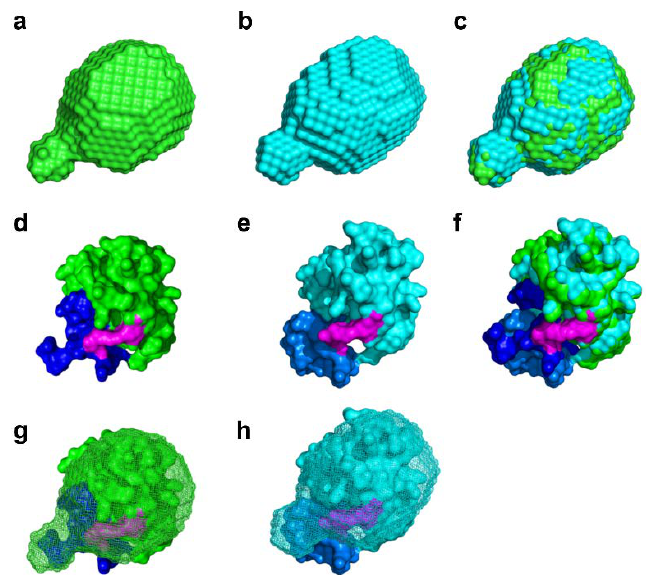
Figure 4. Molecular structures modeled from the low-resolution shape reconstruction and the experiment-restrained rigid-body MD simulation. ( a – c ) Low-resolution shape reconstruction of SML-PYP in the dark ( a ) and light ( b ) states, and the superimposed image ( c ) of DAMMIF filtered results. ( d – f ) Structural representation of SML-PYP in the dark ( d ) and light ( e ) states from the experiment-restrained rigid-body MD simulation, and the resulting superimposed image ( f ). ( g , h ) Comparison of structures from the low-resolution shape reconstruction (mesh) and the experiment-restrained rigid-body MD simulation (sphere-dot) of SML-PYP in the dark ( g ) and light ( h ) states. Blue and marine colors indicate 27 amino acids in the N-terminal region of SML-PYP in the dark and light states, respectively. Green and cyan colors indicate core region of SML-PYP in the dark and light states. Magenta color indicates the BM(PEG) 2 molecule.